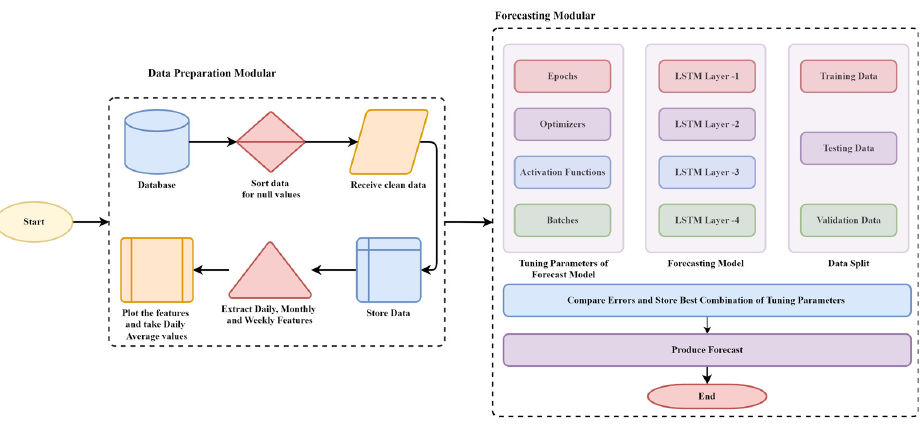
Figure 11. LSTM methodology for the experimental framework.